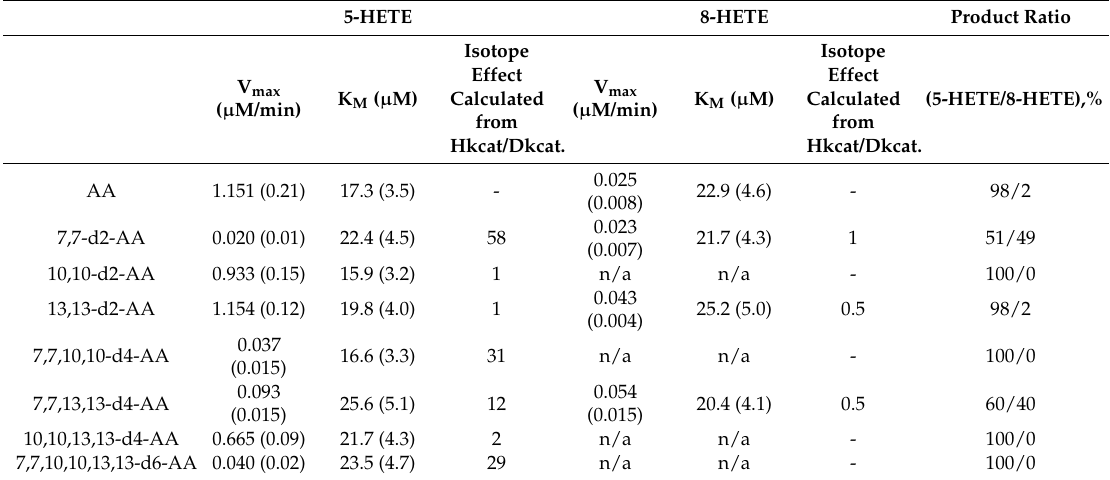
Table 2. Kinetic parameters for the rates of 5-HETE and 8-HETE formation by 5-LOX with AA and deuterated AA using UPLC-MS/MS. Standard deviations are indicated in parentheses. 5-HETE 8-HETE Product Ratio Isotope Effect V max V max K M ( µ M) Calculated ( µ M/min) ( µ M/min) from Hkcat/Dkcat.